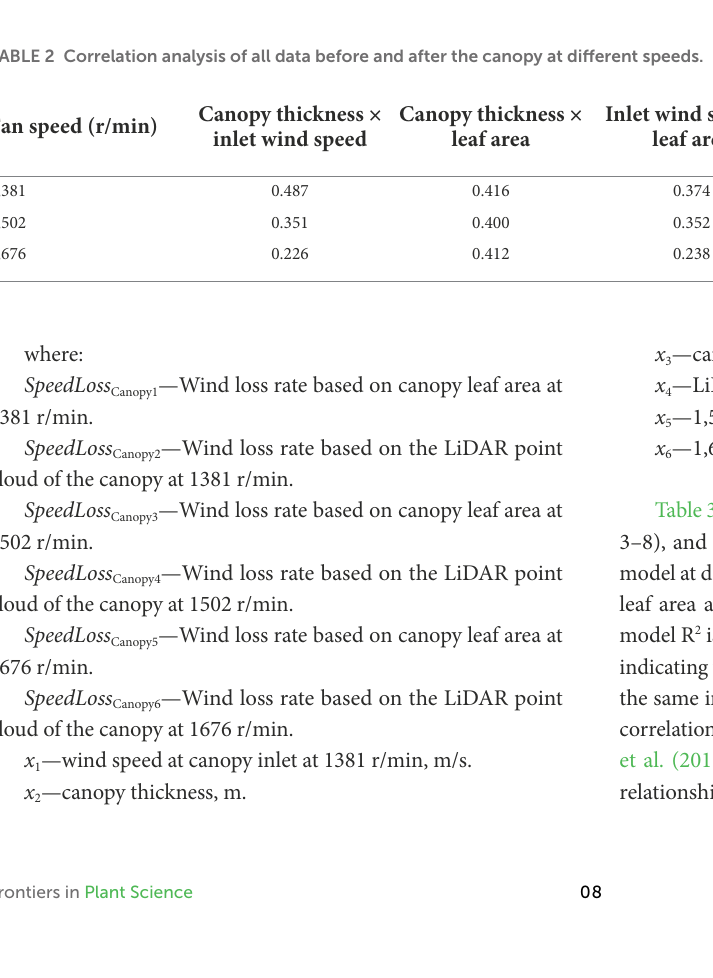
TABLE 2 Correlation analysis of all data before and after the canopy at different speeds.